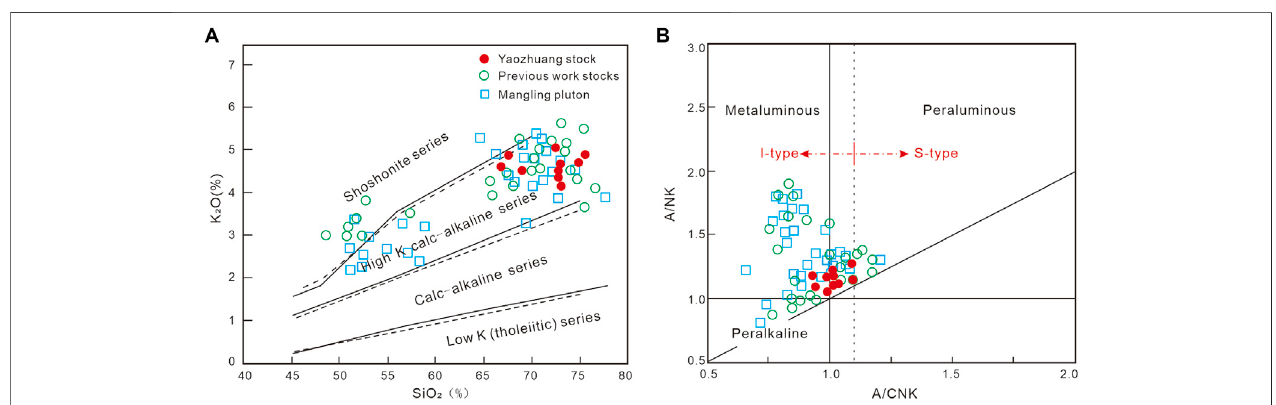
FIGURE 4 | Plots of SiO 2 vs. K 2 O [ (A) after Peccerillo and Taylor, 1976) and A/CNK vs A/NK (B) after Maniar and Piccoli, 1989] of the Yaozhuang stock (previous work stocks data after Ke et al., 2012a; Qin et al., 2012; Yang et al., 2014; Hu et al., 2017; Zhang Y. S. et al., 2019).